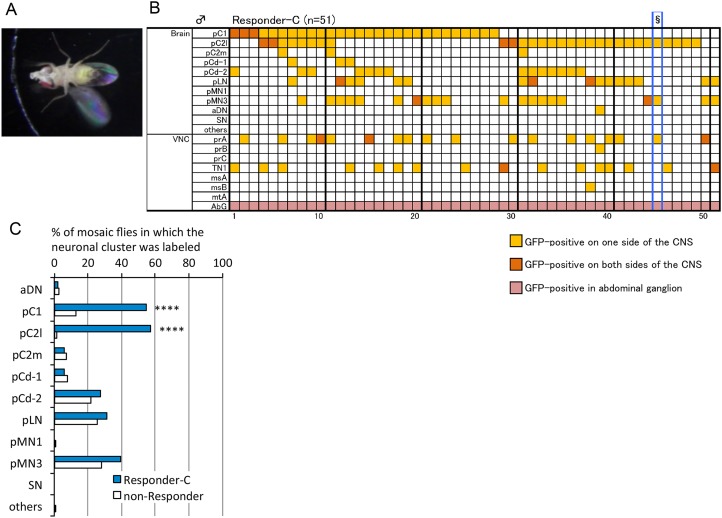
Activation of pC1 and pC2l neurons induces courtship in males.Male flies that carry dTrpA1-expressing MARCM clones were tested for the occurrence of courtship behavior in response to temperature increases, followed by immunohistochemical identification of neurons that were activated in the behavioral assays. We judged that a male responded to a temperature increase by courtship behavior (“Responder-C”) only when it vibrated its wings, while displaying any additional courtship actions, i.e., licking, tapping, and abdominal bending for copulation, and excluded those flies that exhibited wing displays alone without any additional element of courtship behavior, from the count of males positive for courtship responses. (A) Courtship behavior induced by a temperature increase to 35°C in a male carrying MARCM clones expressing dTrpA1. Note that the male is vibrating a wing while licking by extending his proboscis. (B) Labeling pattern of GFP expression in MARCM males. Each vertical column represents the scores of a single fly. Neuronal classes in the brain indicated in the left-hand column are described in Fig 3B and S1 Fig and S1 Table and those in the VNC are described in Ref. 19. § in B indicates that the images shown in Fig 7A, S3G and S3H Fig, and S10 Movie are of this fly. (C) The incidence of GFP-labeling of the indicated neural cluster (signifying dTrpA1 expression) was compared between the Responder-C (n = 51) and the rest of the tested flies (non-Responder, n = 114). GFP-labeling, and thus dTrpA1-mediated activation of pC1 and pC2l but none of the other clusters, was significantly correlated with the occurrence of courtship behavior in mosaic males. **** p < 0.0001, by Fisher’s exact probability test.